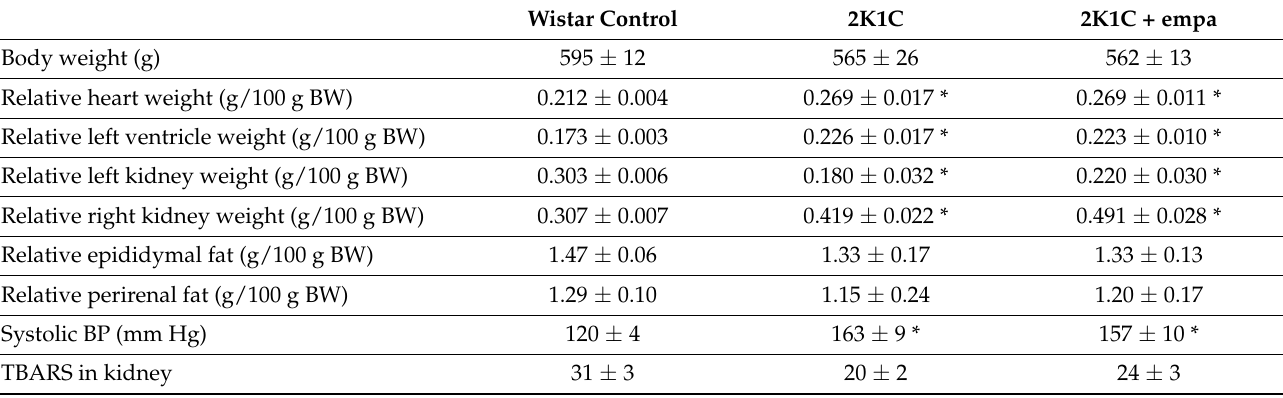
Table 3. Body and organ weights, as well as blood pressure and TBARS levels, in Wistar rats subjected to renal artery stenosis (Goldblatt 2K1C hypertension) treated with empagliflozin